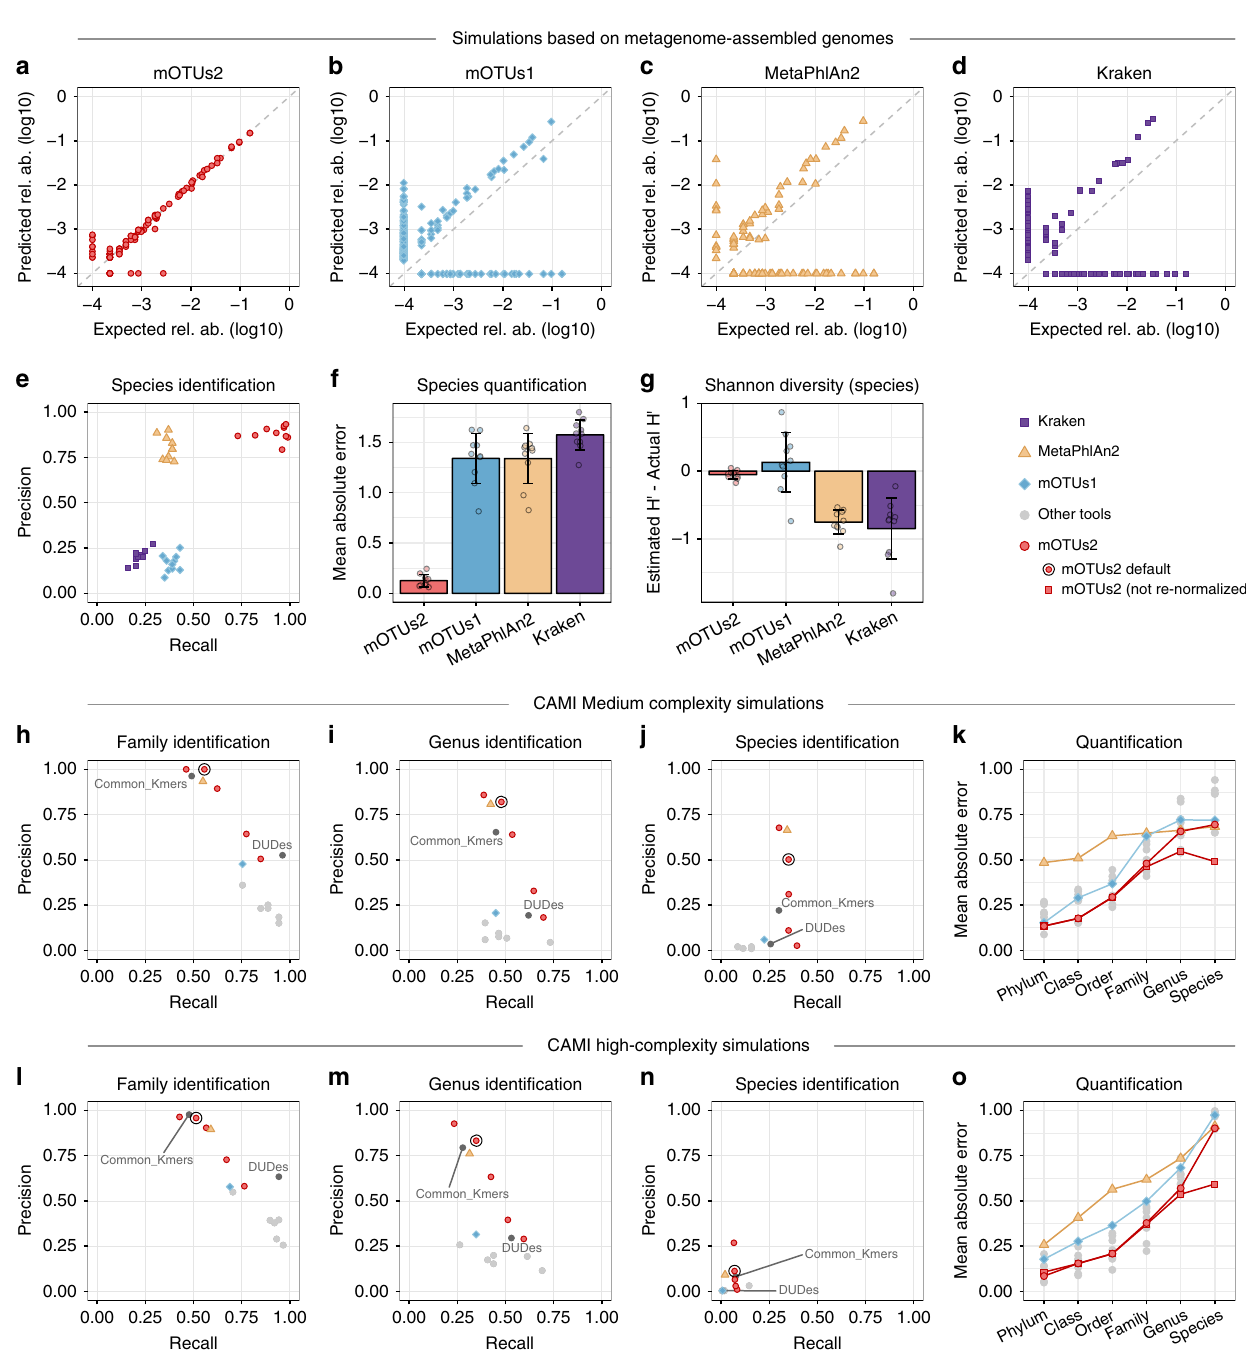
Fig. 2 Evaluation of mOTU pro fi ling on simulated samples. Benchmarks of quanti fi cation accuracy ( a – g ) on ten simulated metagenomic samples (Methods) containing MAGs with ( n = 50) and MAGs without ( n = 50) a representative reference genome sequence, ( h – o ) and the CAMI challenge datasets 25 . a – d A representative simulated metagenome (out of ten; Supplementary Figures 8, 9) analysed with four pro fi lers. e Precision-recall plot, where each data point corresponds to one of the ten simulated samples. Mean absolute error (MAE, also referred to as L1 norm) ( f ) and differences of the Shannon diversity index ( g ) from the expected values (error bars in f and g show standard deviation). h – j Average precision-recall values over the two medium complexity samples and ( l – n ) average precision-recall values over the fi ve high complexity samples of the CAMI dataset